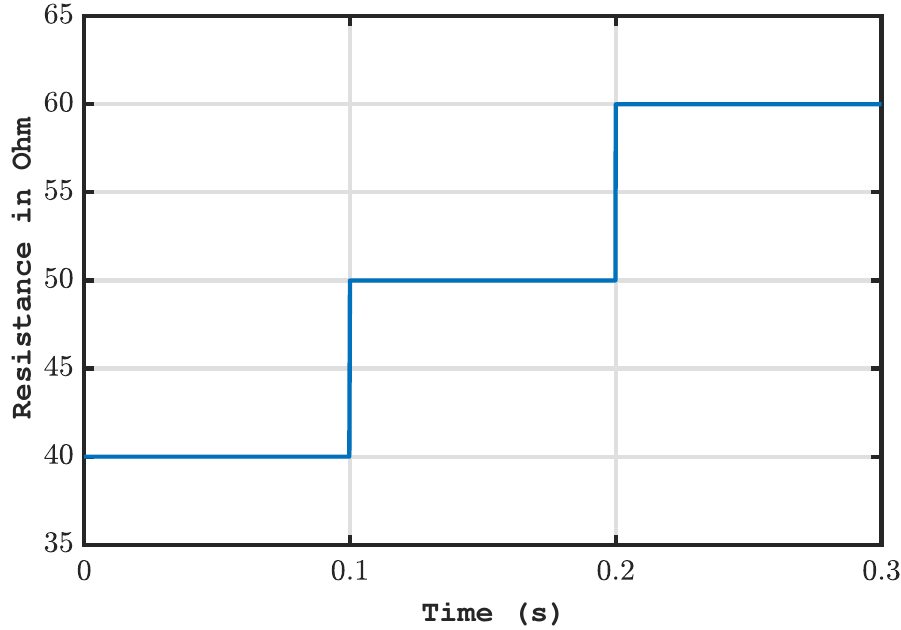
Figure 7. Varying resistive load profile.